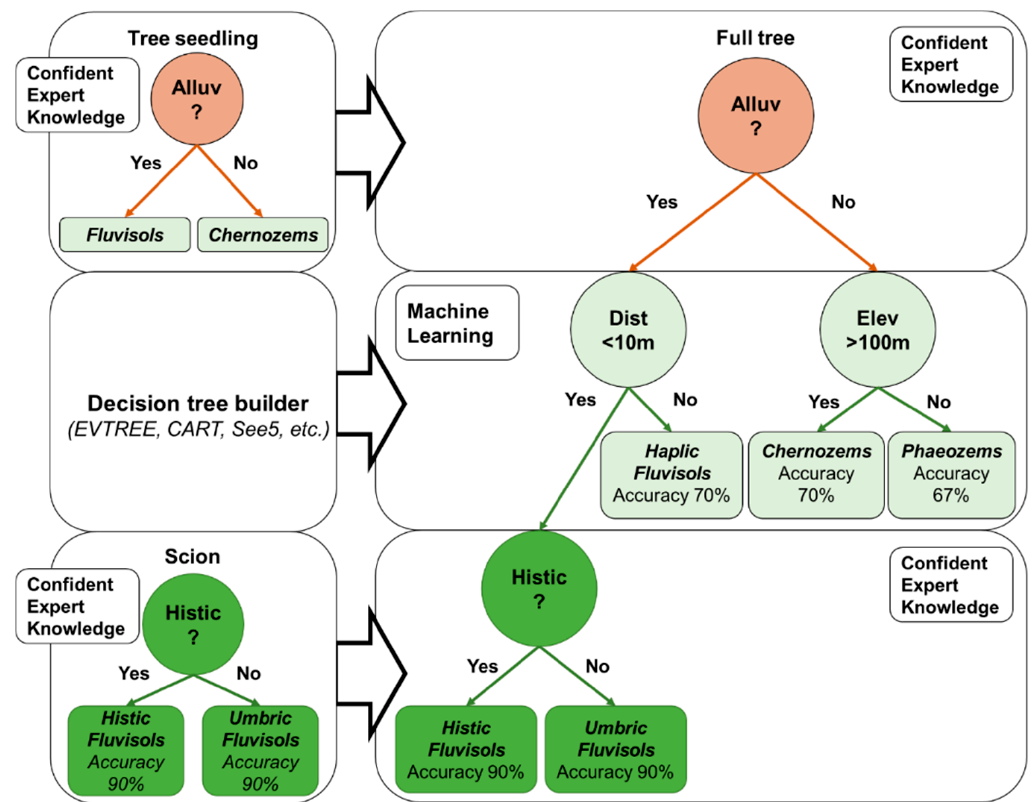
Figure 3. Completing a decision tree of confident expert knowledge with additional branches via machine learning (evtree package). Dist—distance to the nearest river weighted by slopes, Elev—elevation, Alluv—alluvial deposits in floodplains, and Histic—appearance of the Histic soil horizon with organic material (Accuracy: 90% refers to the accuracy of recognizing the soil organic surfaces based on Landsat satellite images).